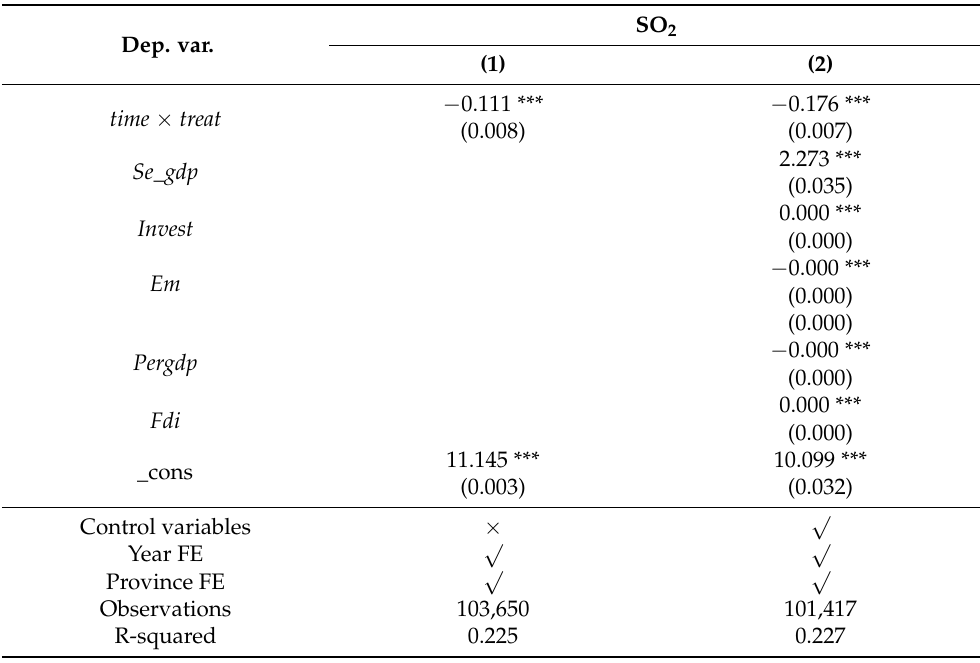
Table A1. Effect of emission trading policy on sulfur dioxide emissions.